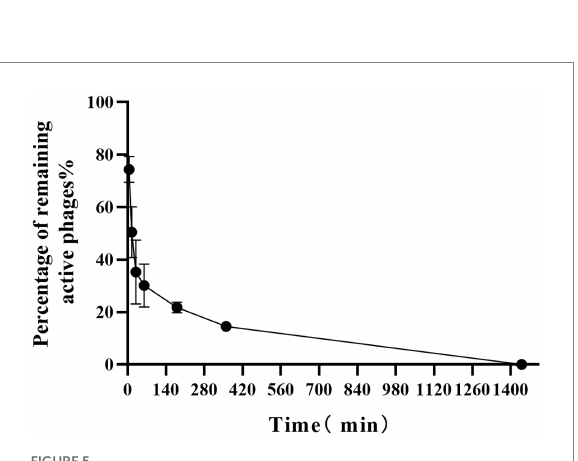
FIGURE 5 In vivo kinetics curve for PaVOA in inoculated New Zealand